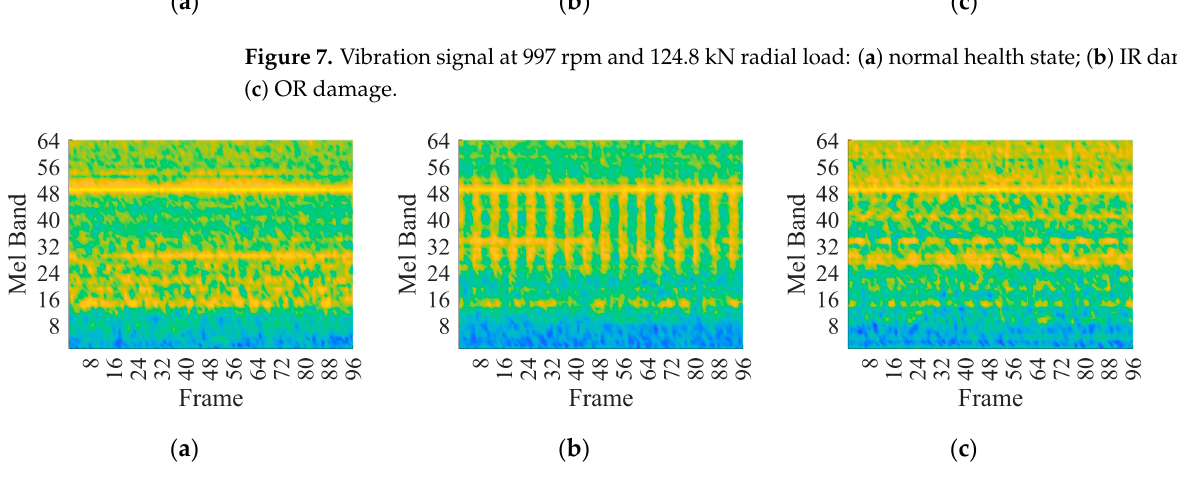
Figure 9. VGGish feature embedding at 997 rpm and 124.8 kN radial load: ( a ) normal health state; ( b ) IR damage; ( c ) OR damage. The model was fine-tuned using the hyperparameters reported in Table 2. The train- ing time was 936 s on a standard laptop without GPU acceleration (Intel ® Core i7 − 10510U CPU @ 1.80 GHz). The model was implemented in the Matlab ® environment by means of machine learning, deep learning and audio toolbox libraries. It is worth noting that the original VGGish structure was trained on multiple GPUs for 184 hours [37]. Figure 10 shows the behavior of the loss functions during the training conducted according to the parameters in Table 2. In particular, the validation set served to monitor potential overfit- ting by analyzing the trend in the validation loss. The number of maximum epochs was set to four (216 iterations), since it was observed that the training process stabilized at this point and overfitting did not occur, though it was detectable during the first two epochs. The accuracies reported in Table 7 reveal the applicability of the diagnosis model to new test data. The complete confusion matrix resulting from the test data is shown in Figure 11. A single normal sample is predicted as OR damaged and a single OR sample is pre- dicted as normal. Therefore, the classifier showed high precision and recall as reported in Table 8. Furthermore, the proposed model was compared with the VGGish model trained from scratch, the YAMNet model [56] and the VGG16 model pre-trained on ImageNet [34,35] proposed by Shao et al. [55]. Table 7 shows the accuracies obtained for the different models, whereas Table 8 reports the precision and the recall for the different classes. The VGGish trained from scratch reaches poor diagnosis accuracies and consistent overfitting phenomena occur. This is due to the fact that the original VGGish architecture was trained on millions of samples. Therefore, the structure is inherently unsuitable for correctly learning hierarchical features over a few thousands of training samples. Given the availa- bility of a limited amount of training data, network weights of millions are extremely prone to overfit the training set. For this reason, TL is the most effective strategy. The